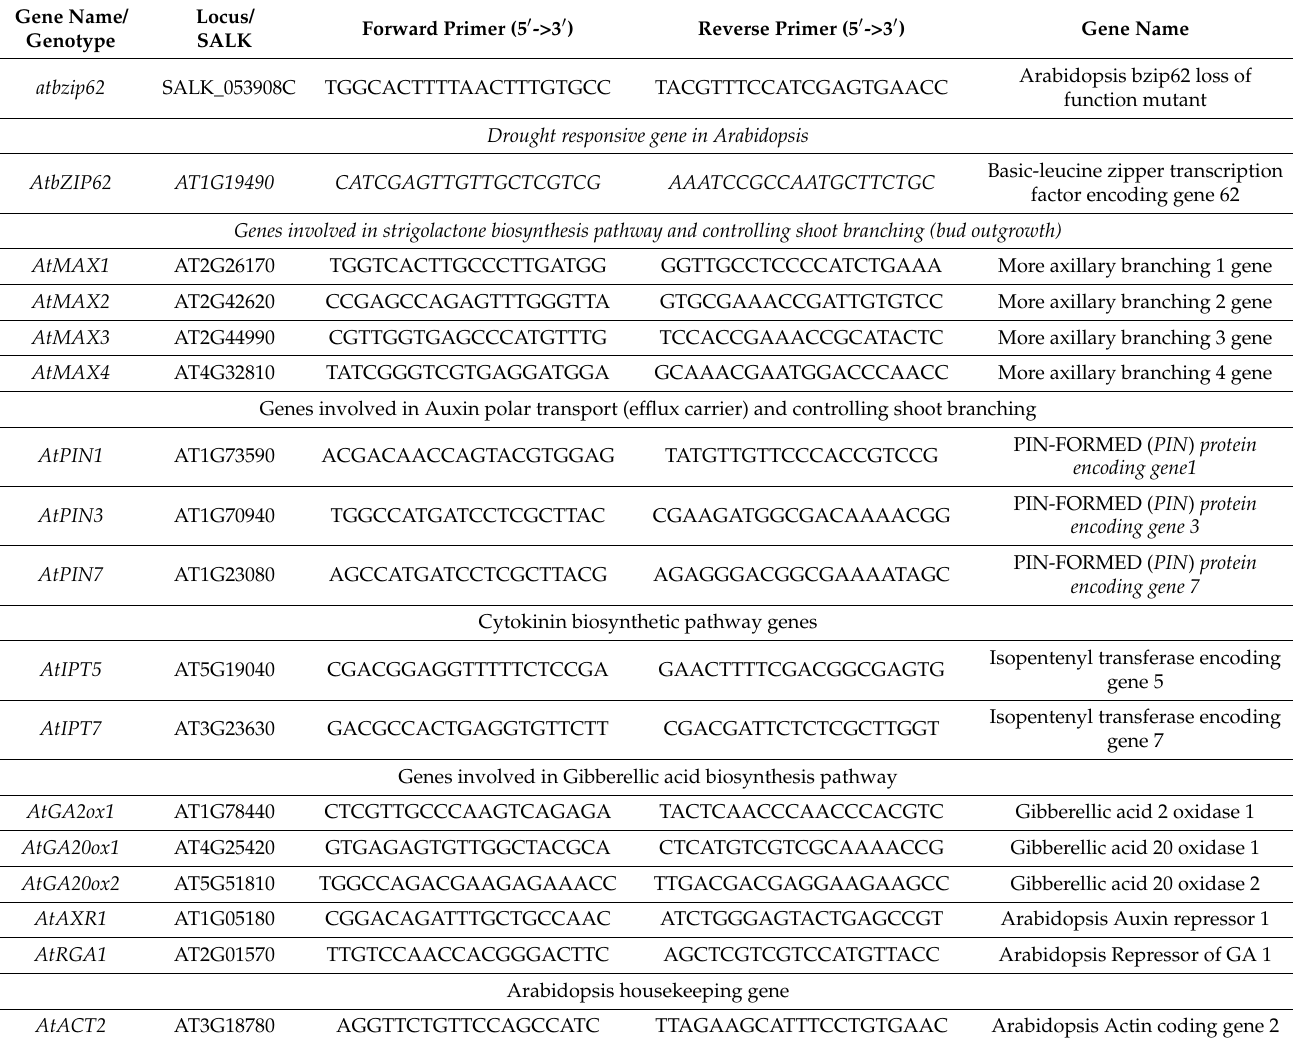
Table 2. List of primers for expression of target genes used in the